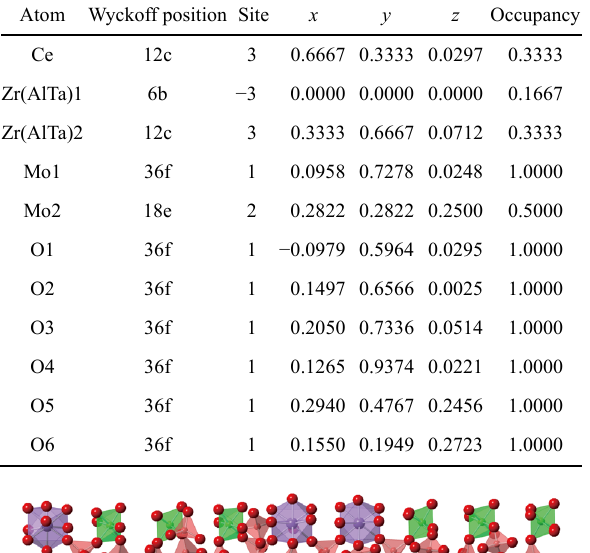
Fig. 3 Lattice parameters ( a , b , and c ) and unit cell volume ( V m ) of CZMAT ceramics as a function of the substitution amount of (Al 1/2 Ta 1/2 ) 4+ . Table 2 Refined atomic positions of CZMAT ceramics